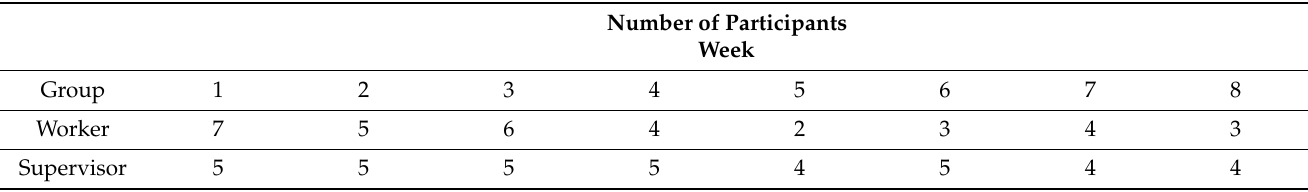
Table 1. Number of participants in each discussion session for both workers and supervisors, who met